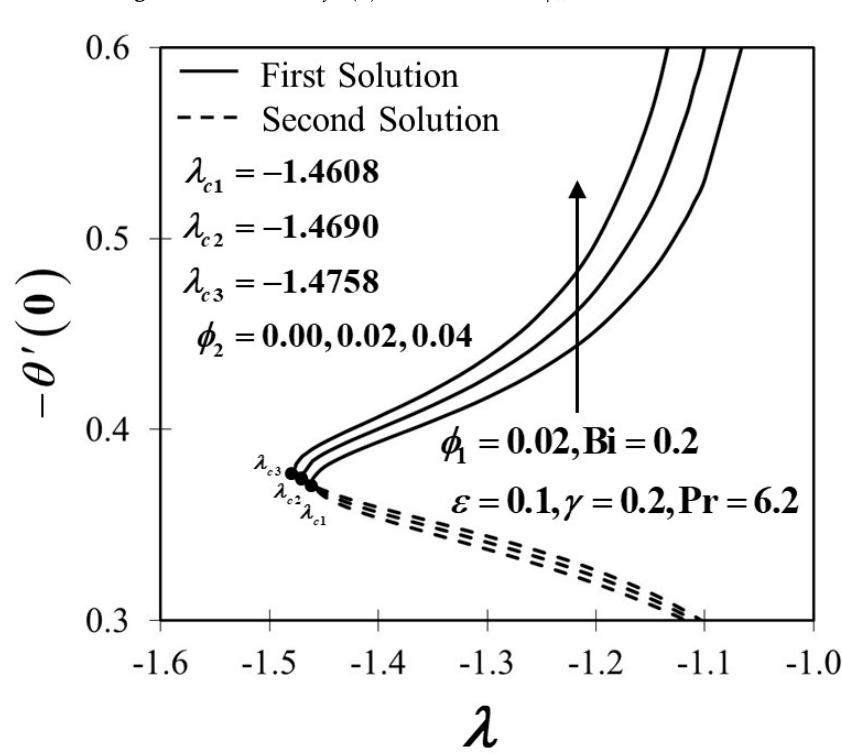
0.00,0.02,0.04. φ = Figure 6. Variants of f